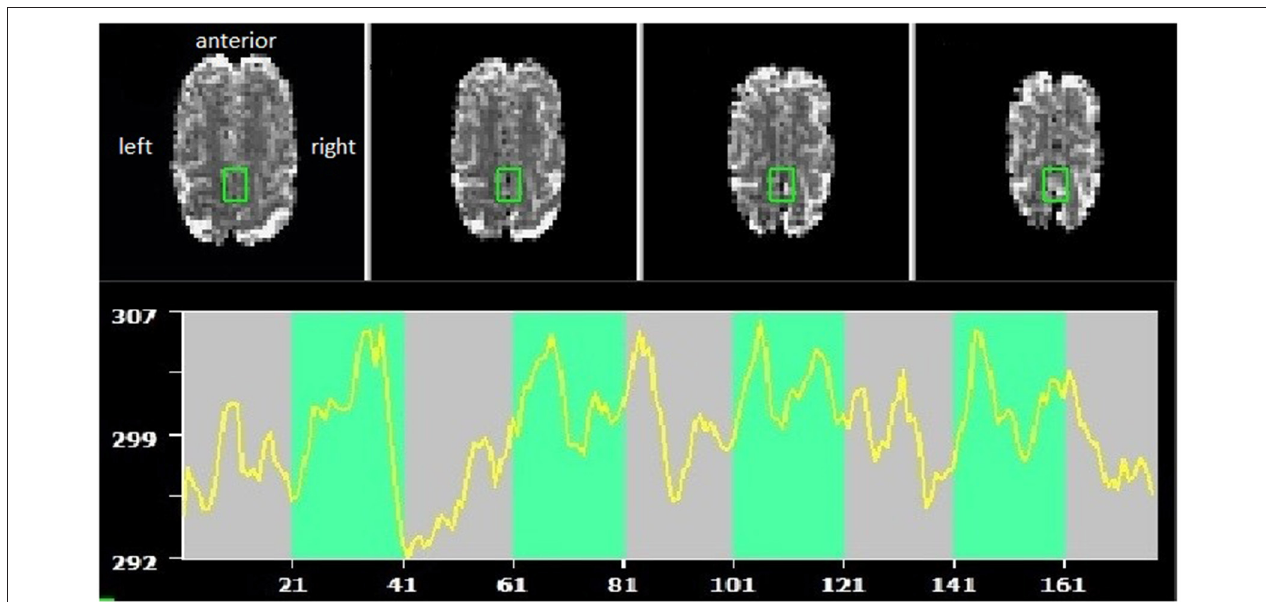
FIGURE 1 | Example of supplementary motor area (SMA) target region of interest (ROI) and self-regulation time course (green indicating the task periods, red rest periods). Radiological convention, with anterior part of the brain shown at the top.